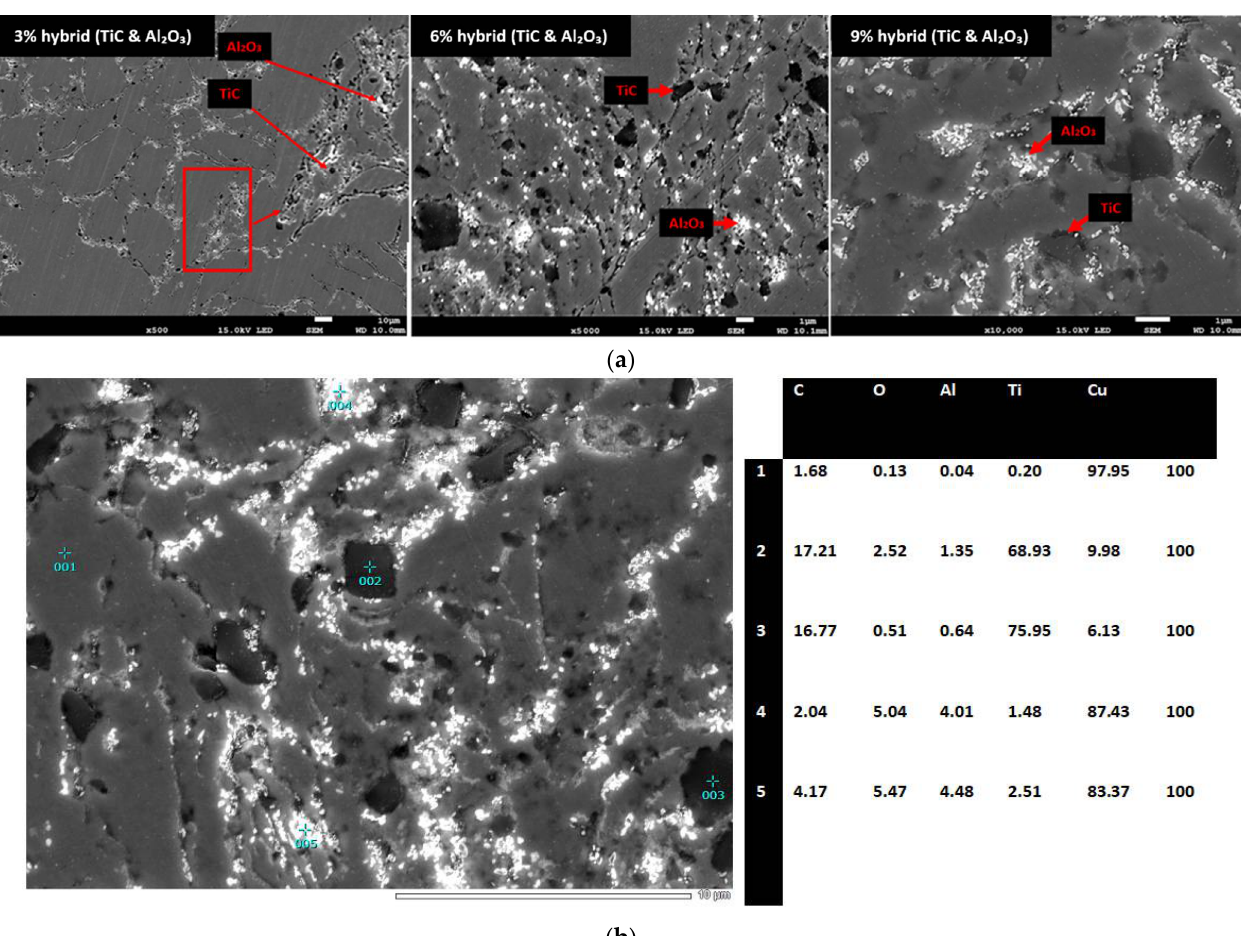
Figure 7. ( a ) SEM of Cu/hybrid nanocomposite with (TiC+Al 2 O 3 ) weight percentage of 3, 6, and 9% prepared using the spark plasma sintered route; ( b ) point analysis for Cu-reinforced hybrid ceramic matrix composite containing 9 wt.% hybrid ratio.